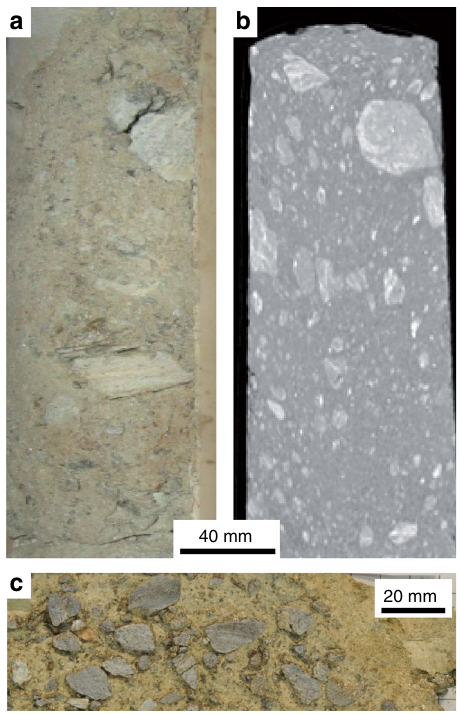
Fig. 6 Example of cataclastic shear zone sample. Sample B4 collected from the cores drilled in the Spriana rockslide: a core sample photo; b CT- scan (longitudinal slice); c and sample longitudinal